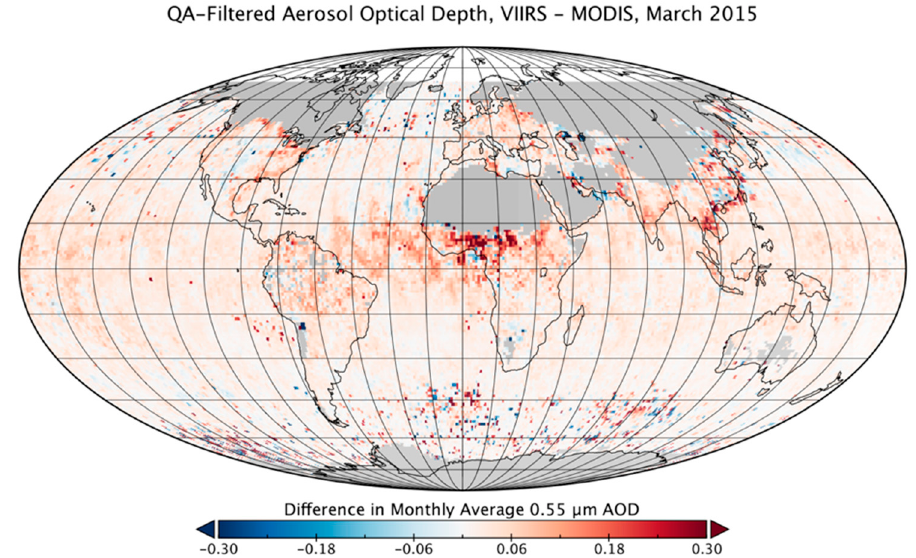
Figure 11. Difference between monthly average QA-filtered 0.55 μ m AOD for March 2015 from VIIRS and MODIS. The global mean difference is +0.02 over ocean and +0.04 over land.